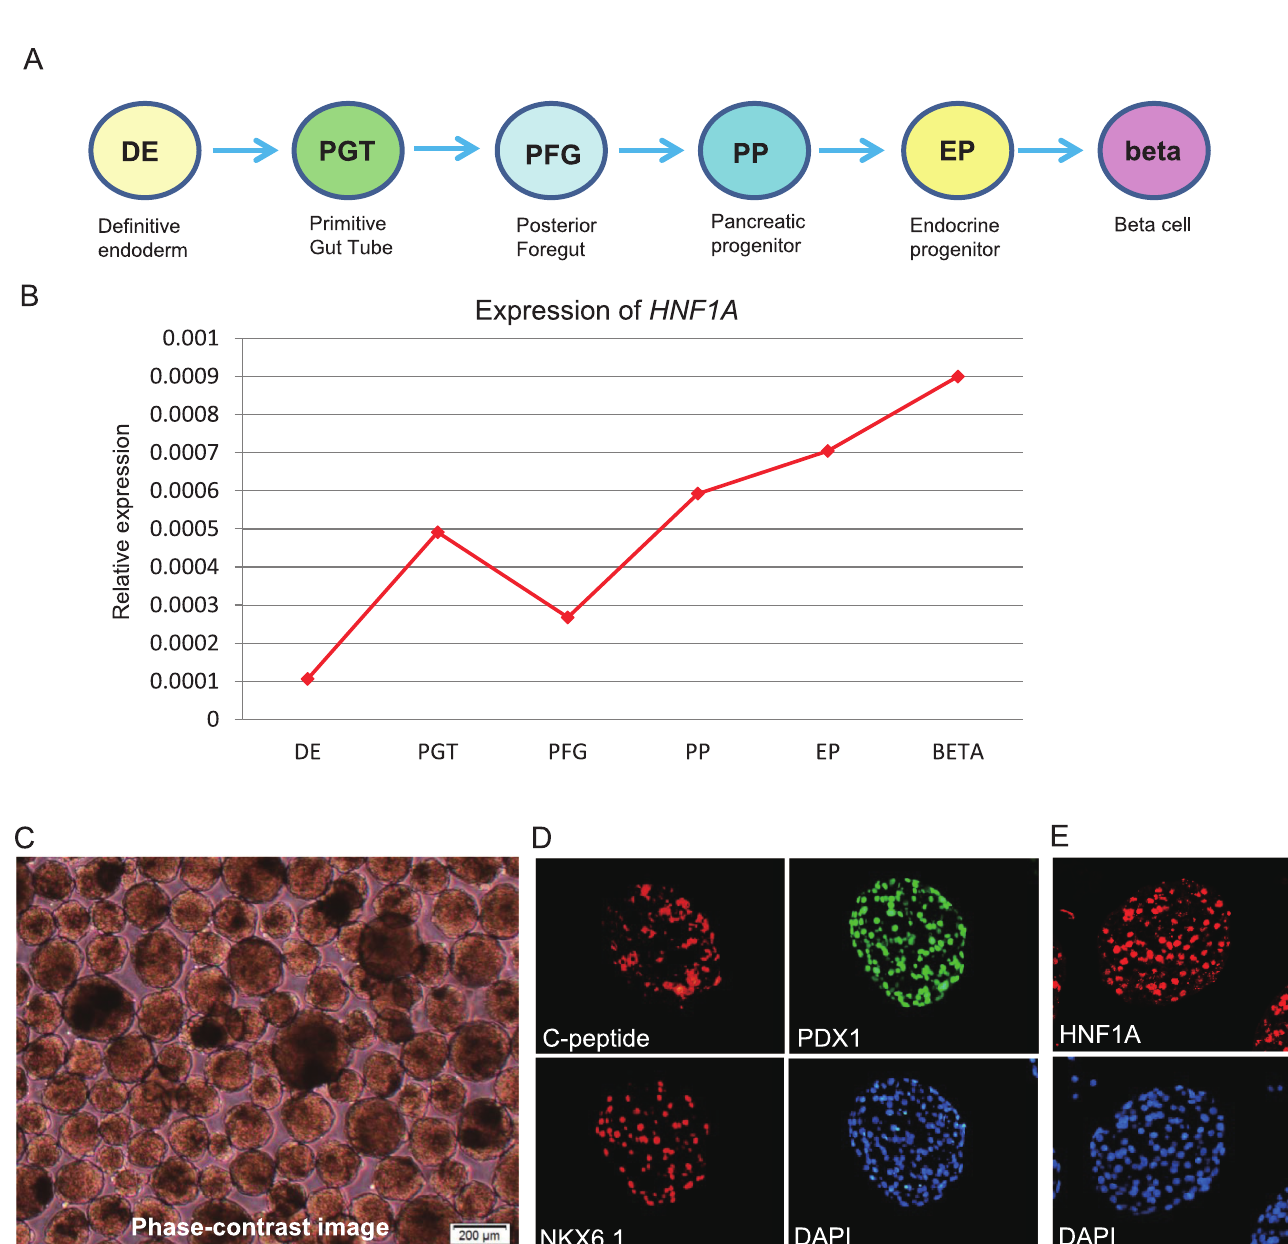
Fig 4. Differentiation of MODY3-iPSCs into pancreatic beta cells. (A) scheme of 6 step differentiation protocol (B), expression pattern of HNF1A mRNA during differentiation process, (C) Phase-contrast image of spheroids of differentiated MODY3-iPS-beta cells, (D, E) Immunocytochemistry of differentiated MODY3-iPS-beta cells for pancreatic beta cell markers (D) C-peptide, PDX1, NKX6.1 and DAPI staining, (E) HNF1A and DAPI staining.